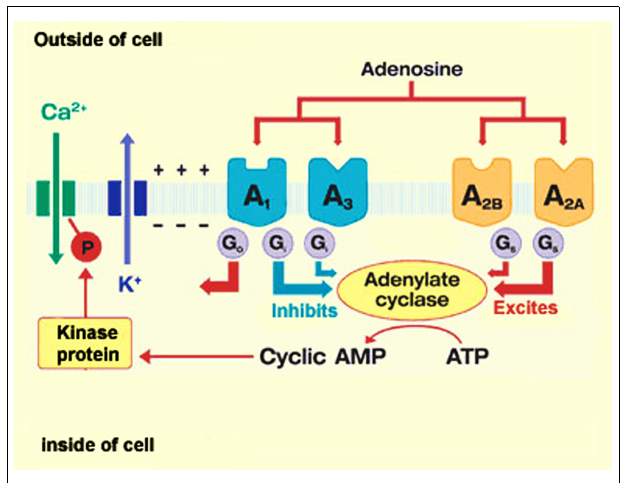
FIGURE 2 |Adenosine receptor signaling. Adenosine mediates its action via four G-protein coupled receptors, A1, A2A, A2B, and A3 that are coupled primarily to the activation and inhibition of cAMP.There is also evidence to suggest that accumulated cAMP is linked to the modulation of ion-channel activity (reprinted from